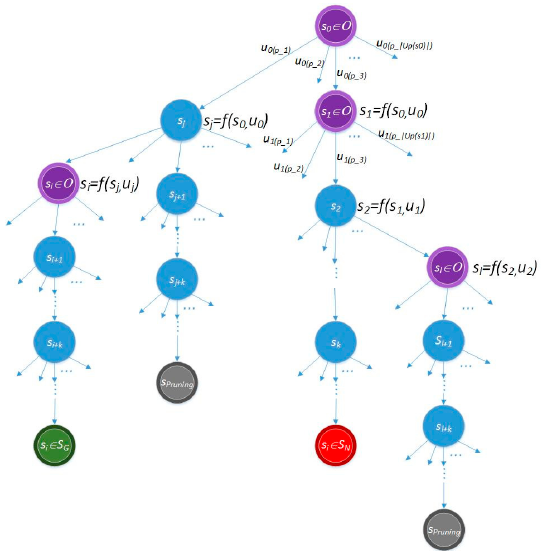
Figure 2. Idea of state graph constructing.